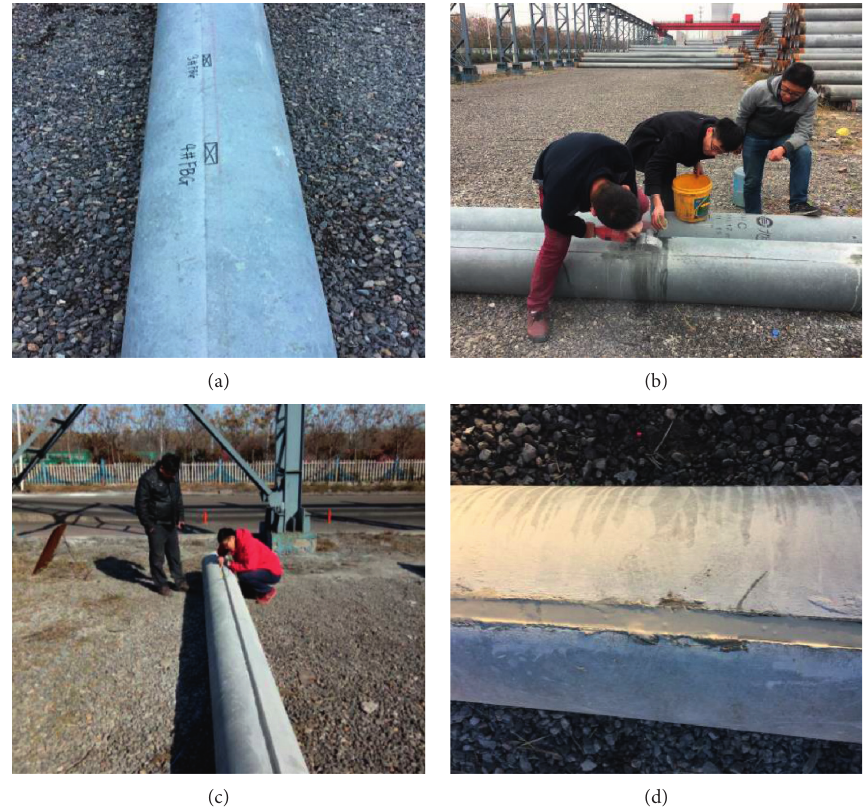
Figure 1: FBG sensor installation process: (a) marking the sensor locations; (b) slotting with a machining tool, (c) installing the sensor, and (d) sealing with epoxy